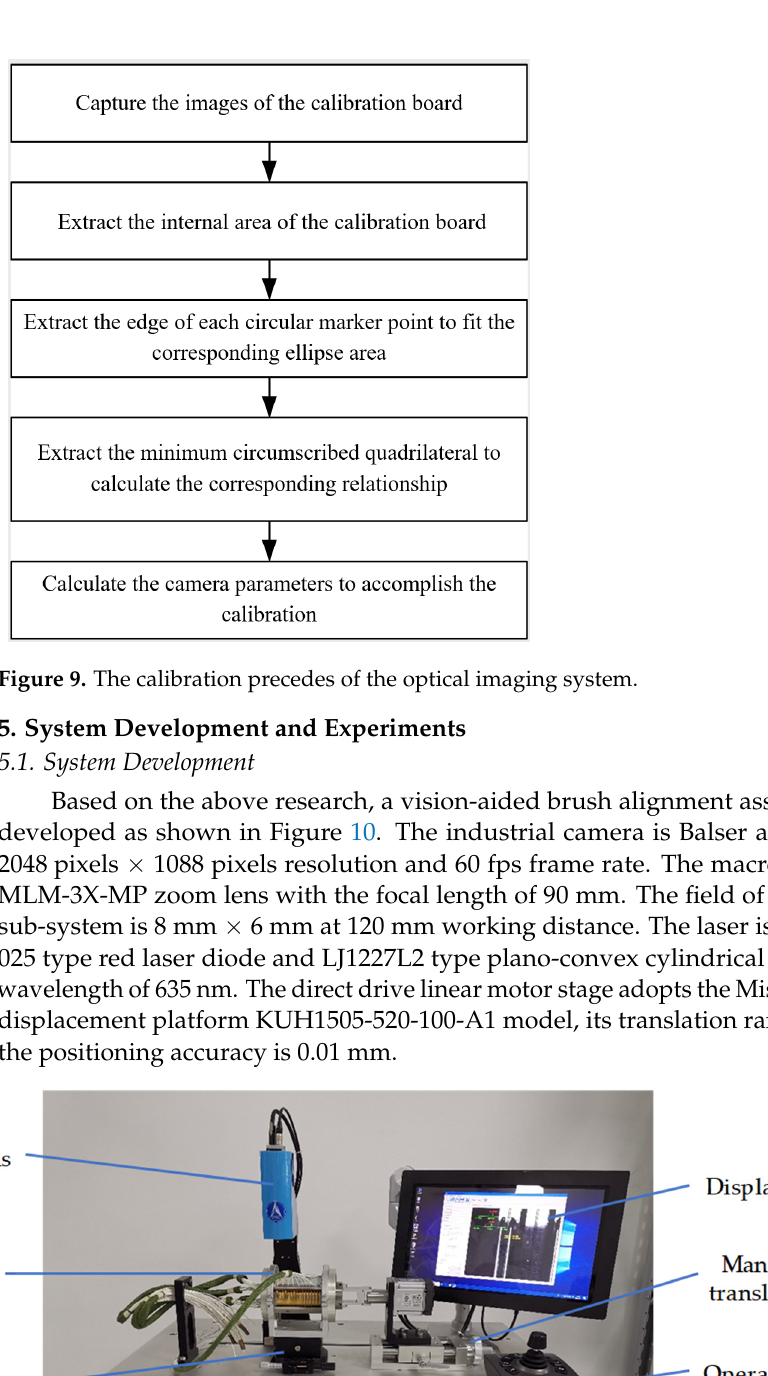
Figure 11. Software developed for vision-aided brush alignment assembly system. Based on the development of hardware and software of the vision-aided brush alignment assembly system, the measured data is intuitively fed back in real time to support the quantitative evaluation of the alignment status between the brush position and the groove position, and can provide the in-situ assembly guidance to the operators, which improves the assembly accuracy and efficiency during the brush assembly process. 5.2. System Calibration In order to accurately obtain the camera parameters, calibration needs to be carried out based on multiple board images from different perspectives. As seen in Figure 12, a high-precision circular calibration board is placed on the worktable, and the placement position and pose of the calibration board is adjusted to obtain the calibration results. The circular calibration board (accuracy of 0.1 µm) has an array of 7 × 7 circular marker points and the diameter of each circular marker point is 1.5 mm. After capturing enough calibration photos for calibration, the calibrated pixel conversion ratio is 0.00685 mm/pixel.